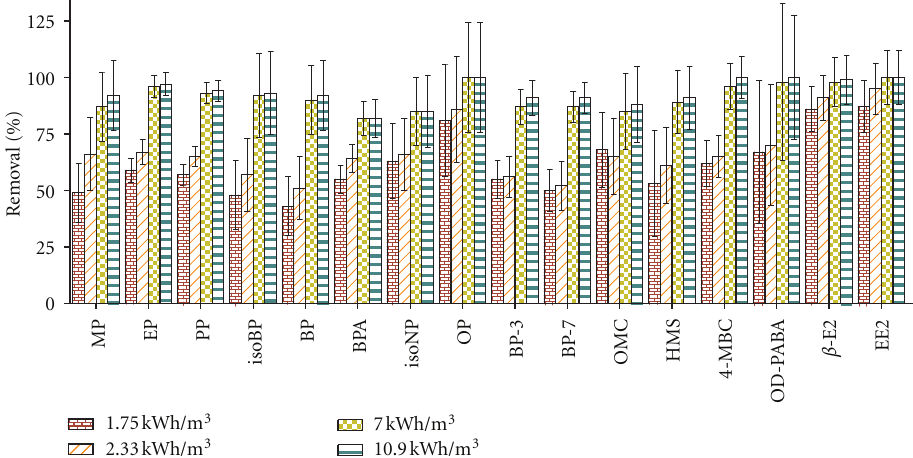
Figure 5: The removal of estrogenic compounds from wastewater e ffl uent by UV/H 2 O 2 . The initial concentration of hydrogen peroxide was 60mg/L. The error bars present the 95% confidence interval. The abbreviation can be found in Table